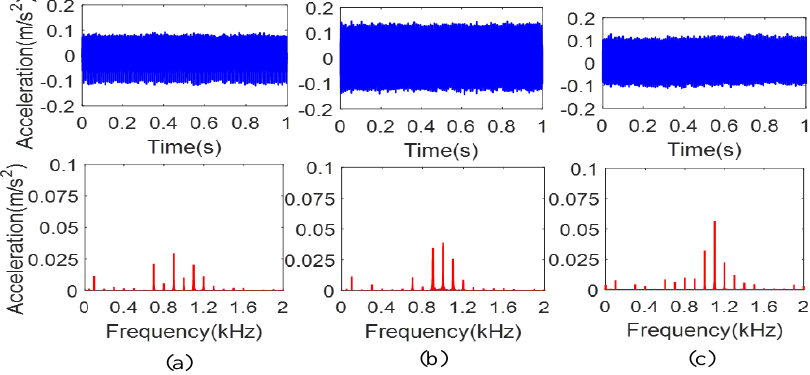
Figure 4. Time domain and frequency domain chart of various classes at 1000 A: ( a ) Class 1; ( b ) Class 2; ( c ) Class 3.